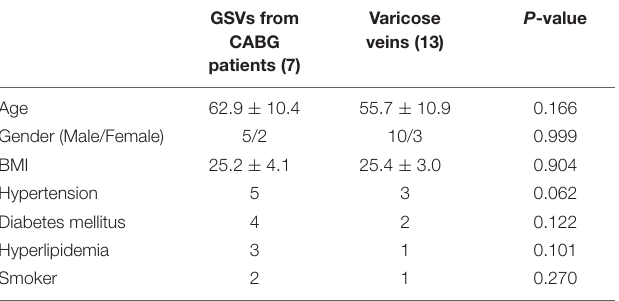
TABLE 1 | Demographics and clinical features of the